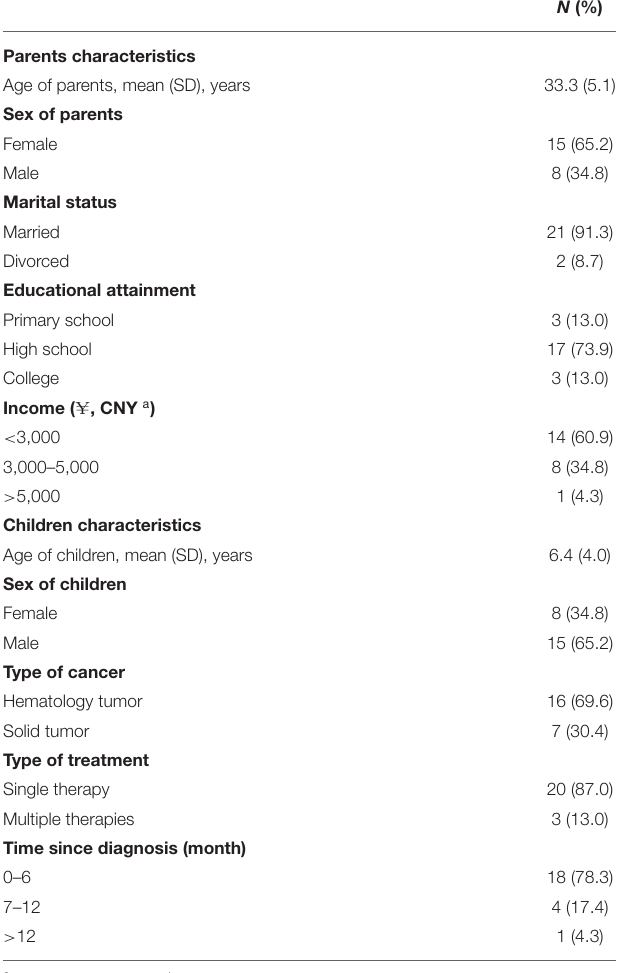
TABLE 1 | Characteristics of parents and children ( N =